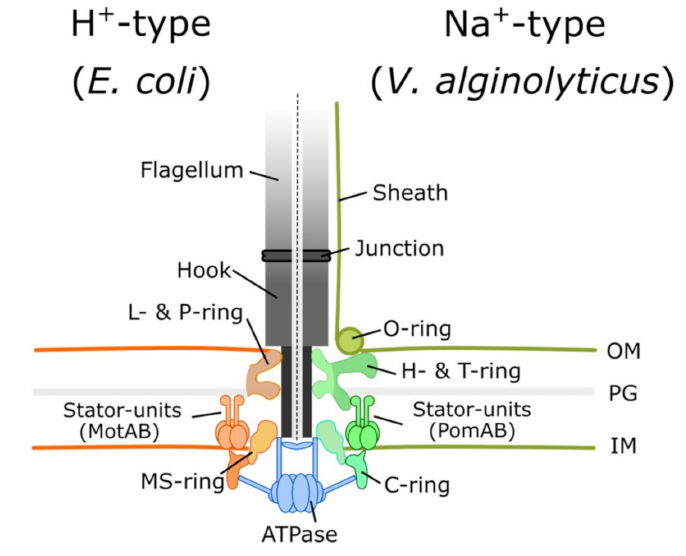
Figure 1. Bacterial flagellar motors are mainly classified into proton-driven and sodium-driven motors. Torque generation requires an interaction between stator units and FliG on the C-ring. In the proton-driven motor of E. coli , the stator is composed of MotA and MotB, whereas PomA and PomB are sodium-driven analogues in V. alginolyticus . The common elements for both motor types are LP, MS, and C rings. In V. alginolyticus , an additional sheath covers the flagellar